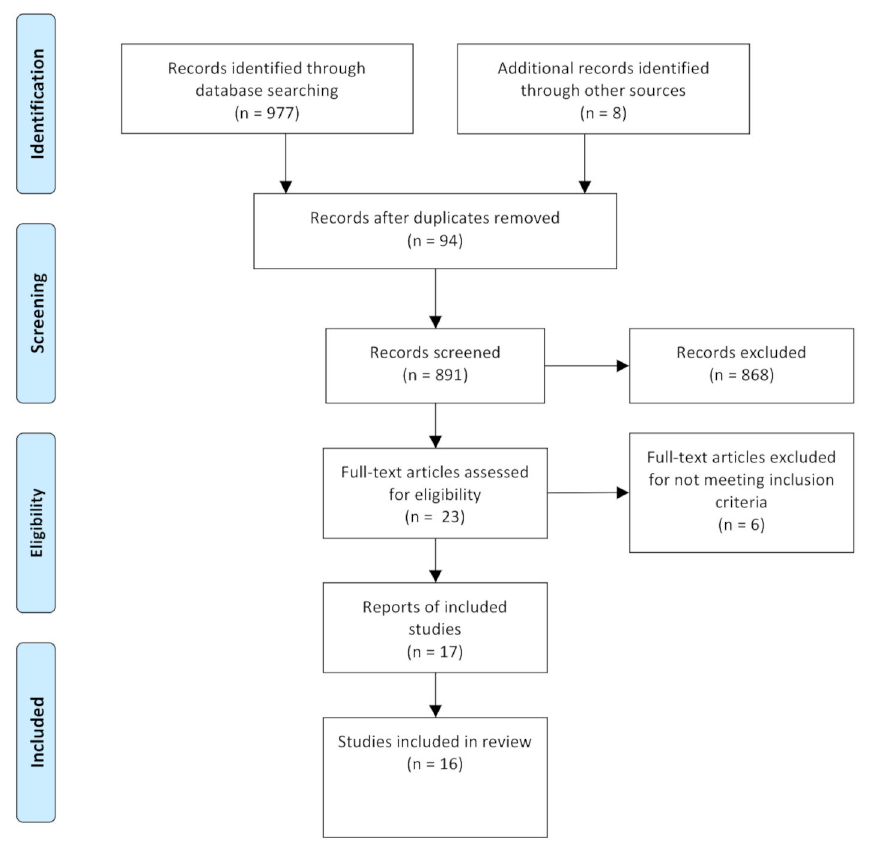
Figure 1. Flow diagram of the search results.